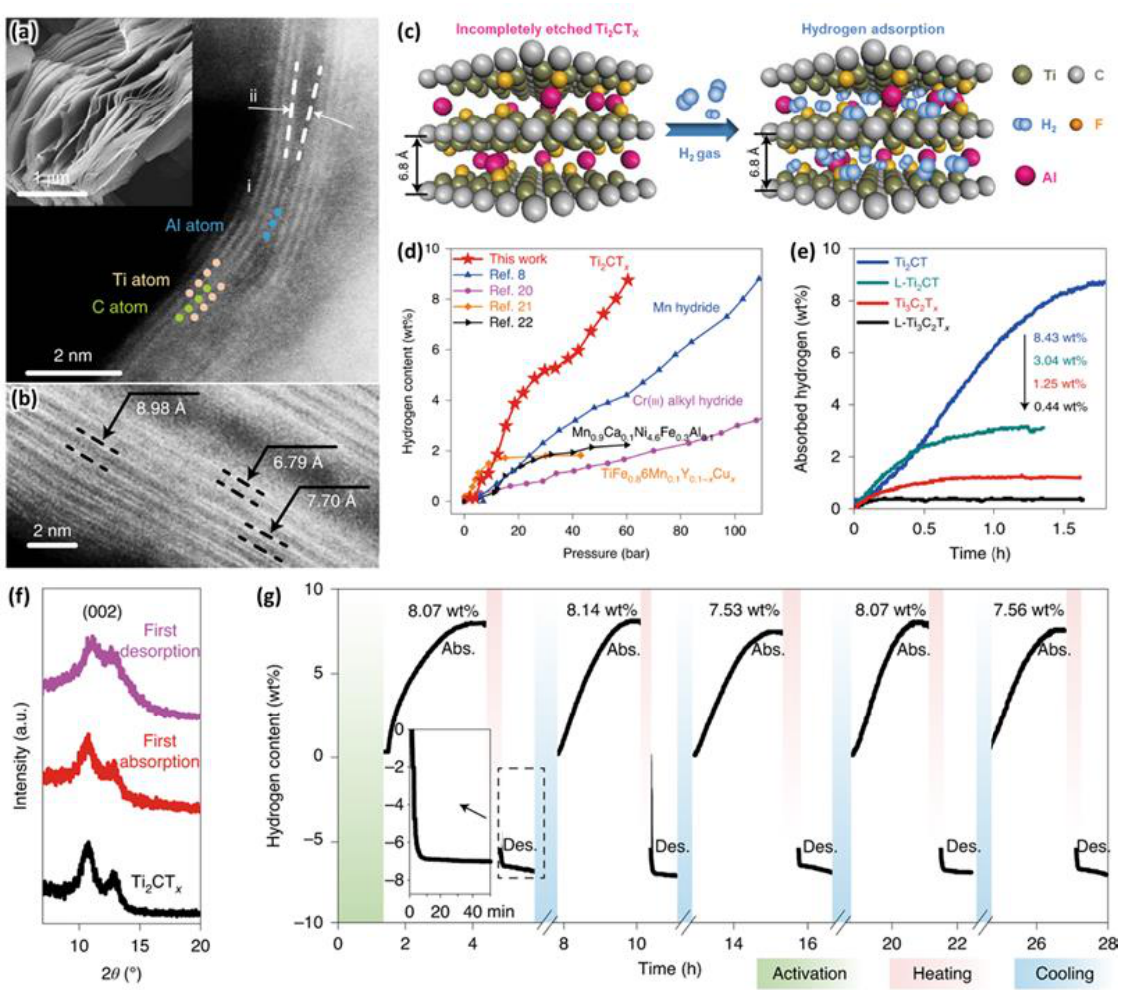
Figure 11. ( a , b ) TEM images of an MXene for hydrogen storage with a bell-mouth structure, ( c ) the hydrogen storage mechanism on an incompletely etched MXene, ( d , e ) hydrogen uptakes of MXene samples at 298 K and 60 bar, ( f ) XRD patterns of pristine, hydrogenated, and dehydrogenated MXene, and ( g ) hydrogen uptake cycles. Reproduced from ref. [140]; copyright (2021) with permission from Nature Research.